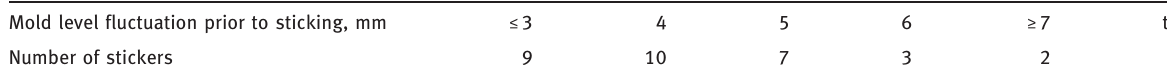
Normally, the liquid level of the mold fluctuates within 3 mm. Mold level fluctuation prior to sticking is investi- gated by the above 31 samples of the sticker, as shown in Table 2. From the table, mold level fluctuation prior to sticking is bigger or equal to 4 mm in 22 stickers. The bigger liquid-level fluctuation is one key factor of indu- cing sticker. As shown in Figure 2, the liquid-level fluc- tuation reaches about 9 mm prior to one sticker breakout.